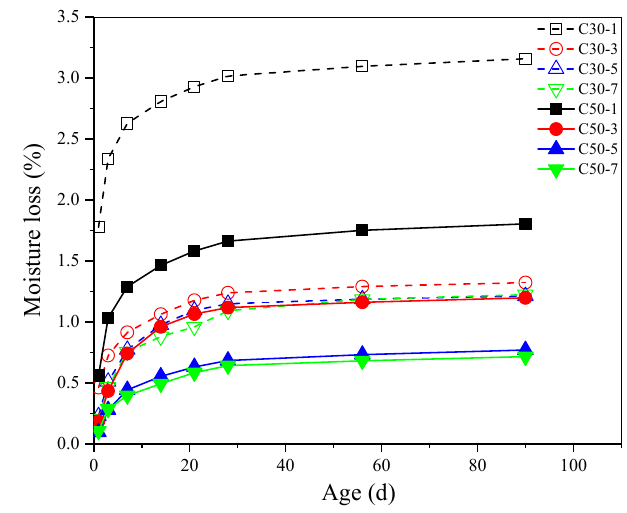
ff ect of early age curing on moisture loss of Figure 4. Effect of early age curing on moisture loss of AASC. Figure 4. E Figure 4. Effect of early age curing on moisture loss of AASC.